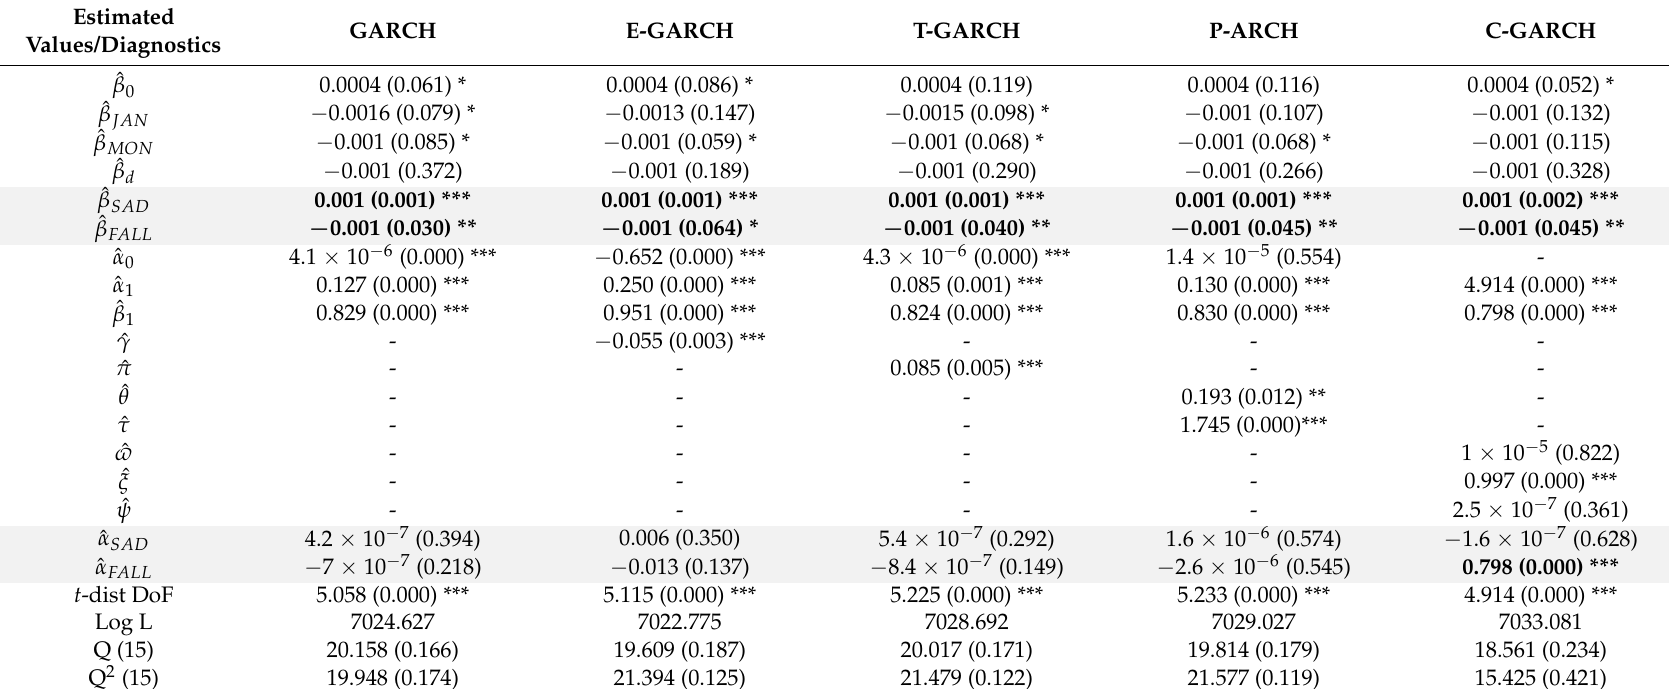
Table A2. Different GARCH specifications for